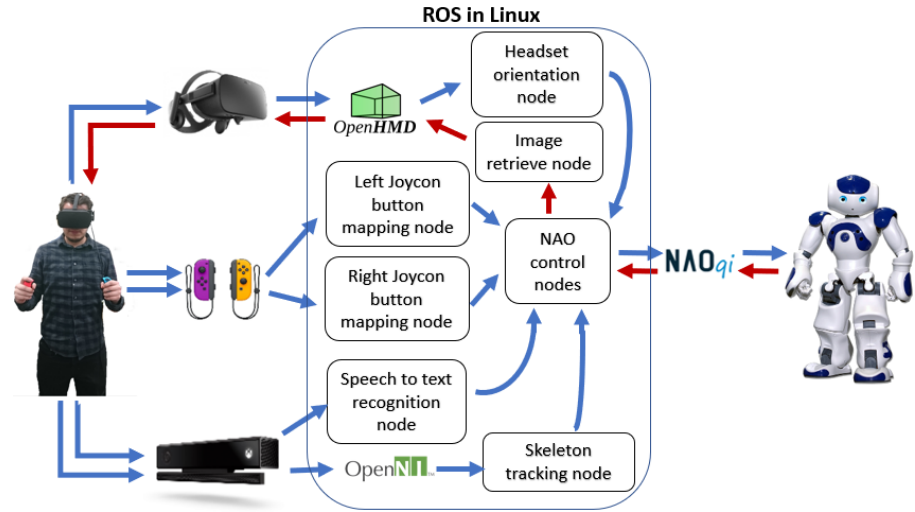
Figure 5. Modular software architecture of the teleoperation model: consists of different nodes to read out data from Kinect, Meta Quest, and Joycon Controllers and another module to control the robot. The blue lines indicate position data measured or actions on the operator side and resulting into motion or operation of the NAO robot. The red lines indicate visual data collected on the robot and provided as feedback to the operator.